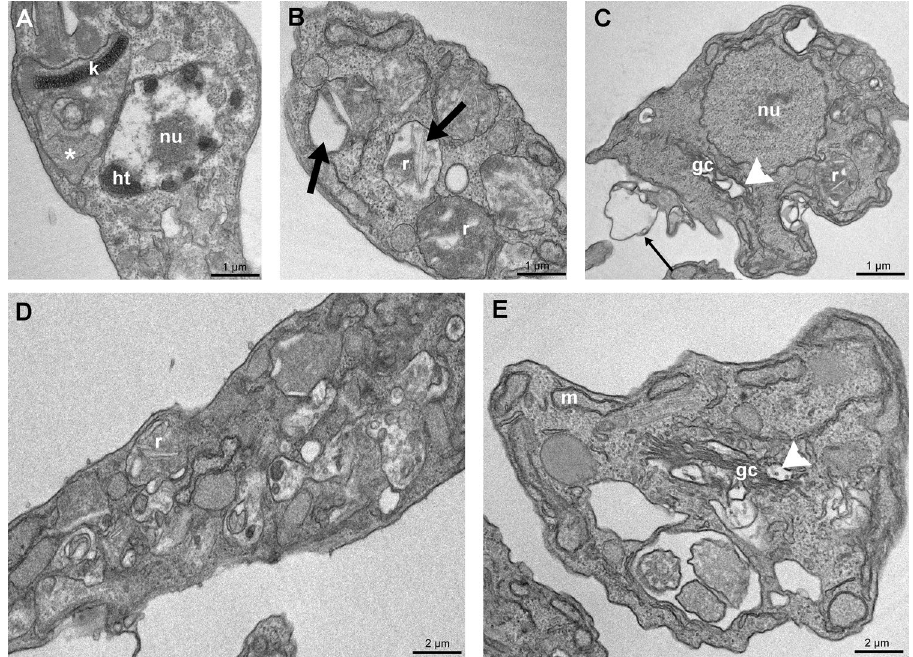
Figure 7. Transmission electron microscopy of T. cruzi epimastigotes after removing FEX from the medium. ( A ) Parasites previously treated with 20 µM presented kinetoplast swelling (asterisk). ( B ) Epimastigotes treated with 30 µM showed alterations on reservosomes ultrastructure (thick arrow). ( C – E ) Parasites were treated with 40 µM. Note the unpacking of nuclear heterochromatin, plasma membrane detachment (thin arrow), intense cytoplasmic disorganization contrary to the continuous treatment, and Golgi complex disruption (white